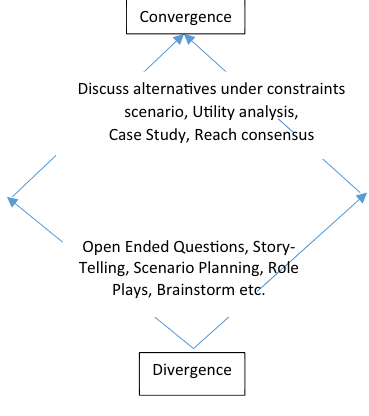
Figure 1. Divergent-convergent diamond